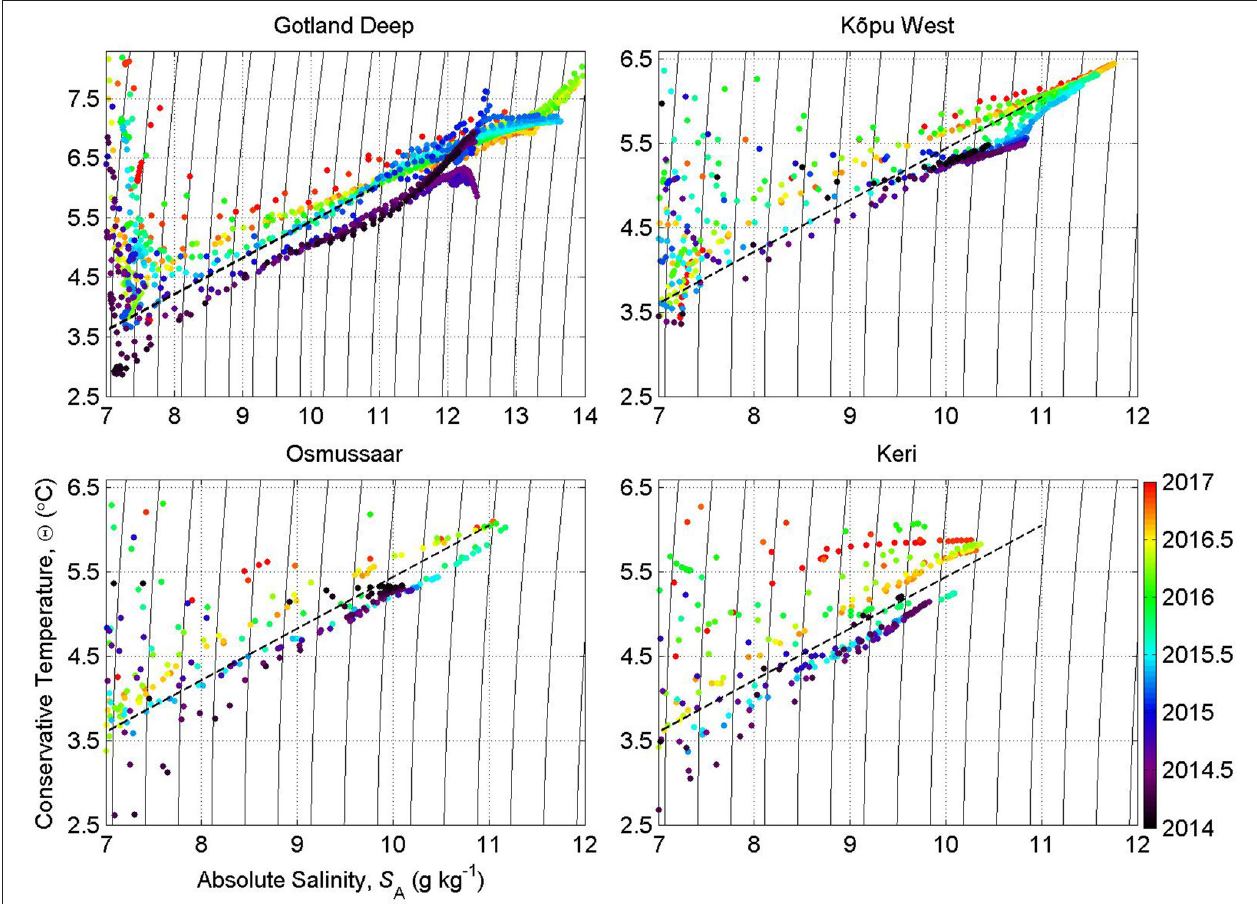
FIGURE 9 | Temporal development of temperature-salinity in the Gotland Deep, Kõpu West, Osmussaar, and Gulf of Finland (Keri). Color scale represents years. Black dashed line was added to make data in subplots better comparable. Note that limits of y-axis are different for the Gotland Deep subplot and rest of the